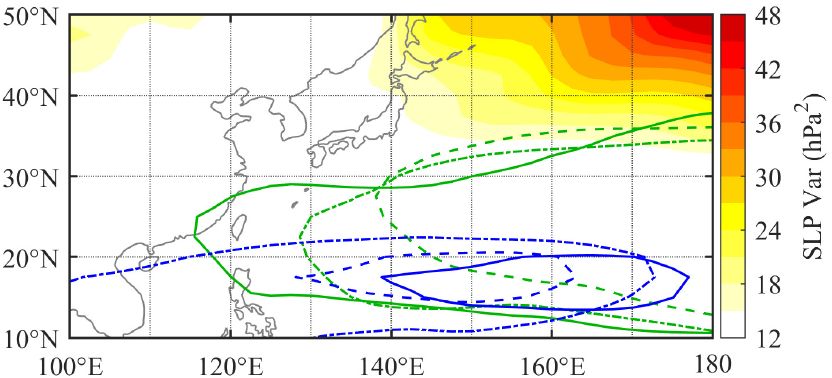
Figure 2. The sea level pressure (SLP) filtered variance (color shading, unit: hPa 2 ) of National Centers for Environmental Prediction (NCEP) reanalysis-1 for the 3-year (2017–2019) boreal winter. The green (blue) solid, dashed, and dash-dot curves denote seasonally averaged boundaries of the Western Pacific subtropical high-pressure (WPSH) systems in the summer (winter) of 2017, 2018, and 2019, respectively.